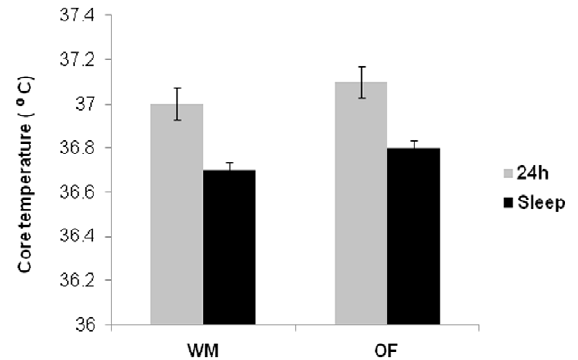
Figure 3. Twenty four hour and sleep core temperature. Mean 24 h (white column) and sleep (gray column) core temperatures were 37.0 6 0.2 ( u C), 36.7 6 0.2 ( u C) respectively on WM, and 37.1 6 0.2 ( u C), 36.8 6 0.2 ( u C) respectively on OF; both mean 24 h core